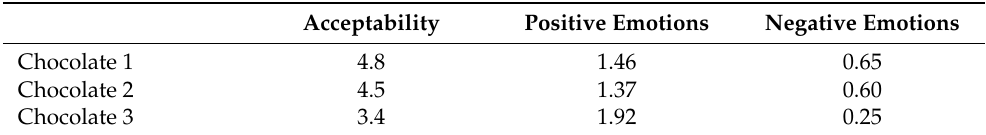
Table A1. Mean values of consumers’ acceptability and positive and negative emotions of three chocolate